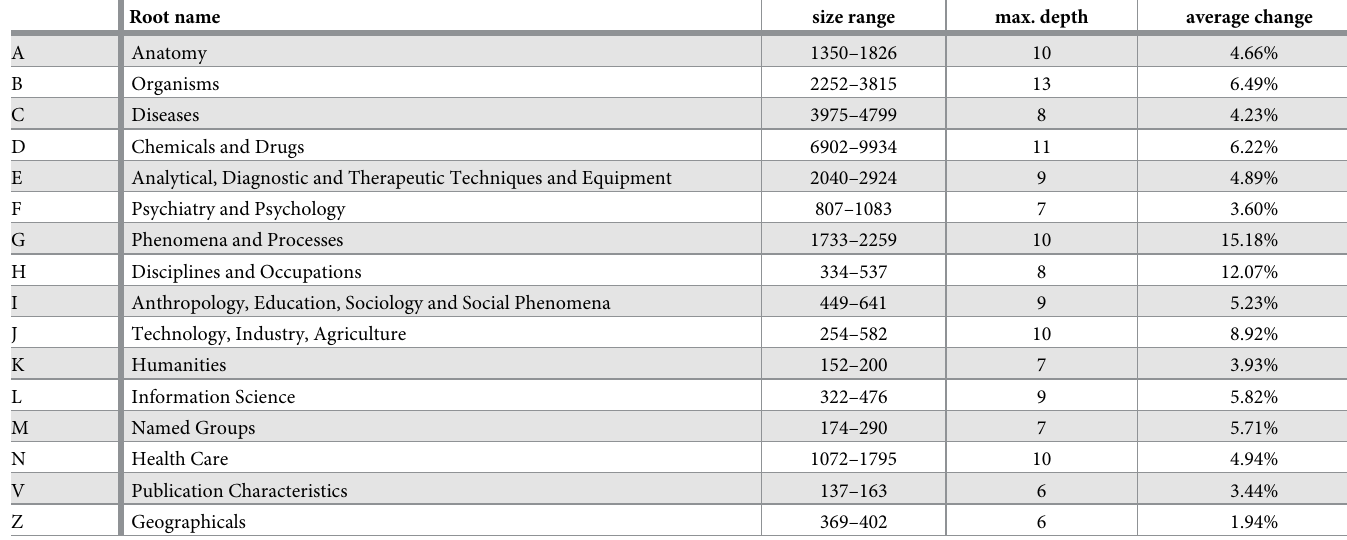
Table 1. Basic hierarchy